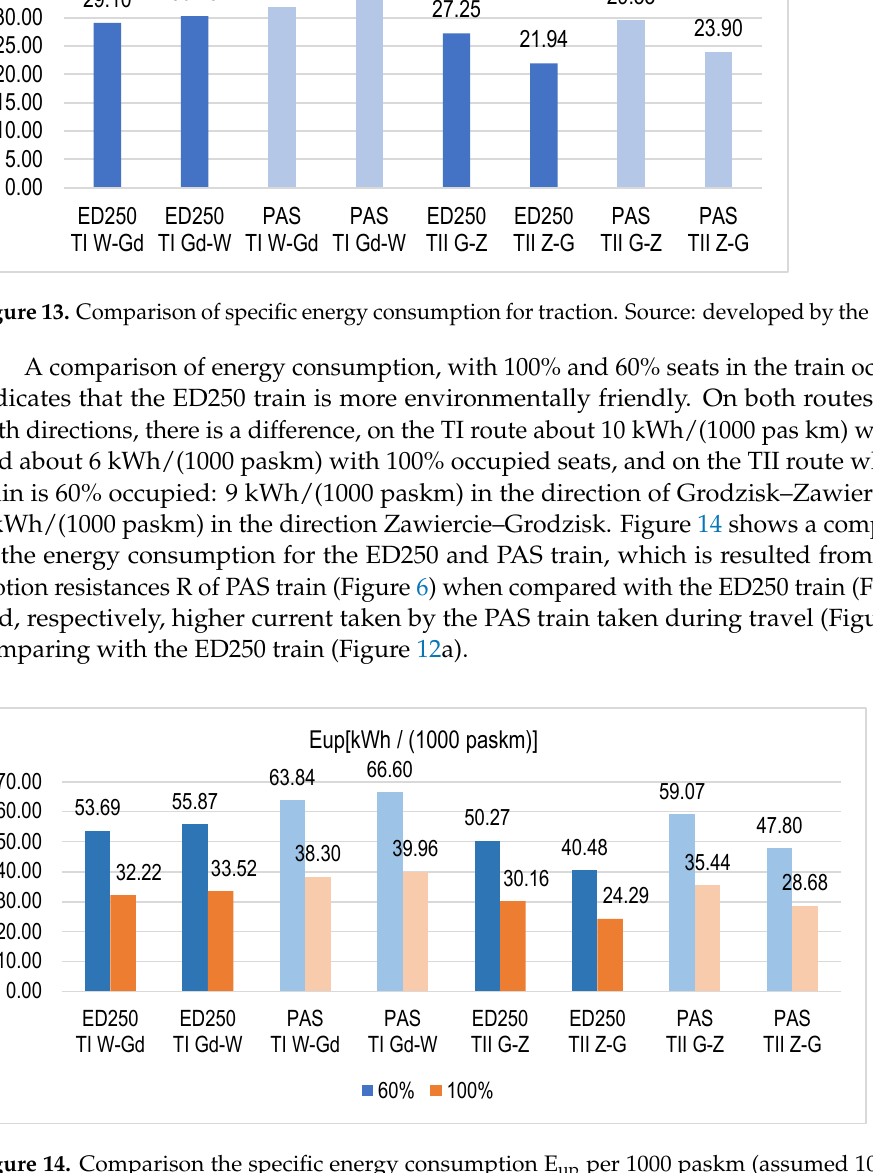
Figure 14. Comparison the specific energy consumption E up per 1000 paskm (assumed 100% and 60% nominal load). Source: developed by the authors.